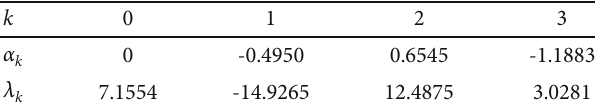
Table 6: Parameters for the MaxEnt distribution with m = 3